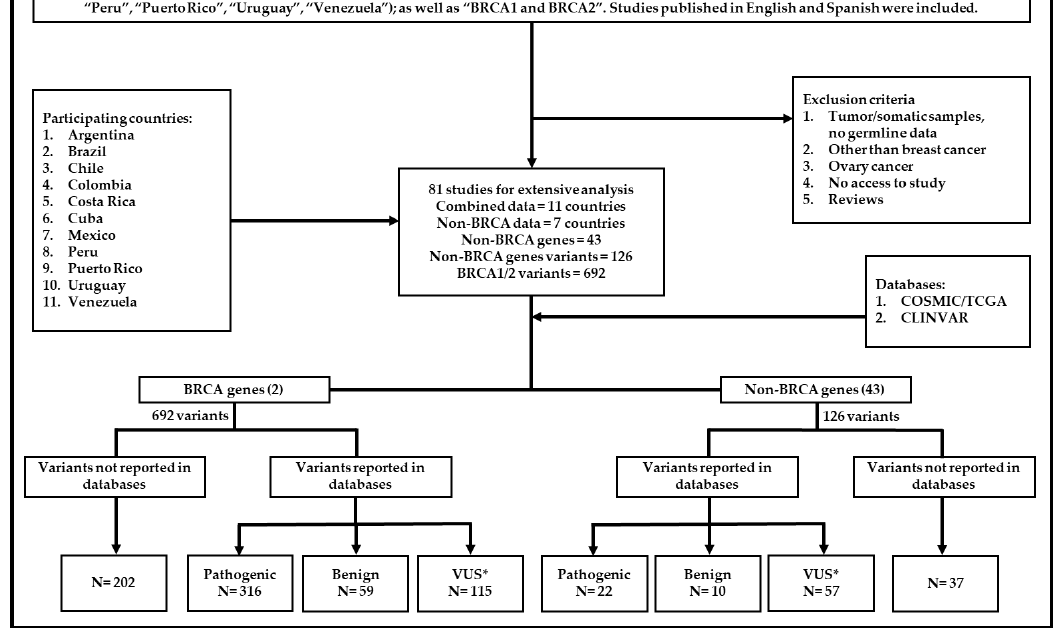
Figure 1. Study diagram. This diagram shows data acquisition and variant classification. *VUS: conflicting interpretation, uncertain significance, likely pathogenic, likely benign, risk factor, drug response.